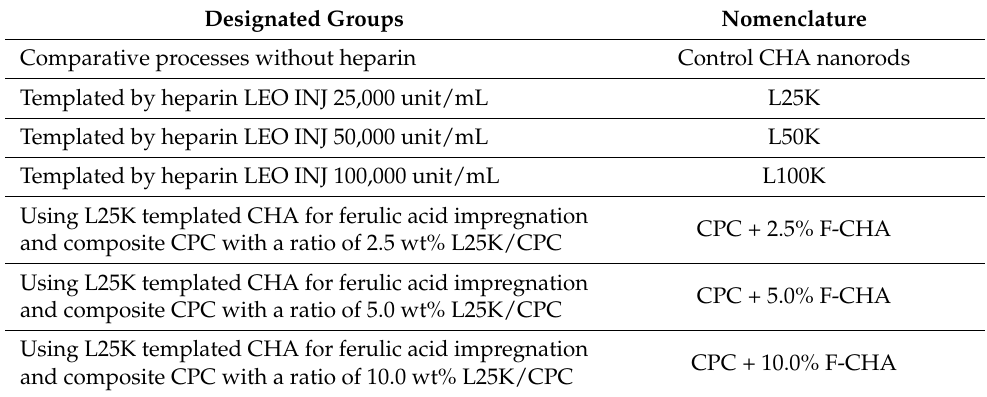
Table 1. Nomenclature of different groups prepared in this work. Pharmaceutical heparin was used as a template to prepare CHA nanorods and graft ferulic acid